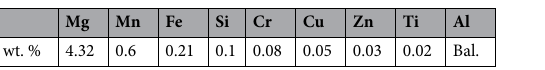
Table 1. Composition of AA5083 used in this study (determined by